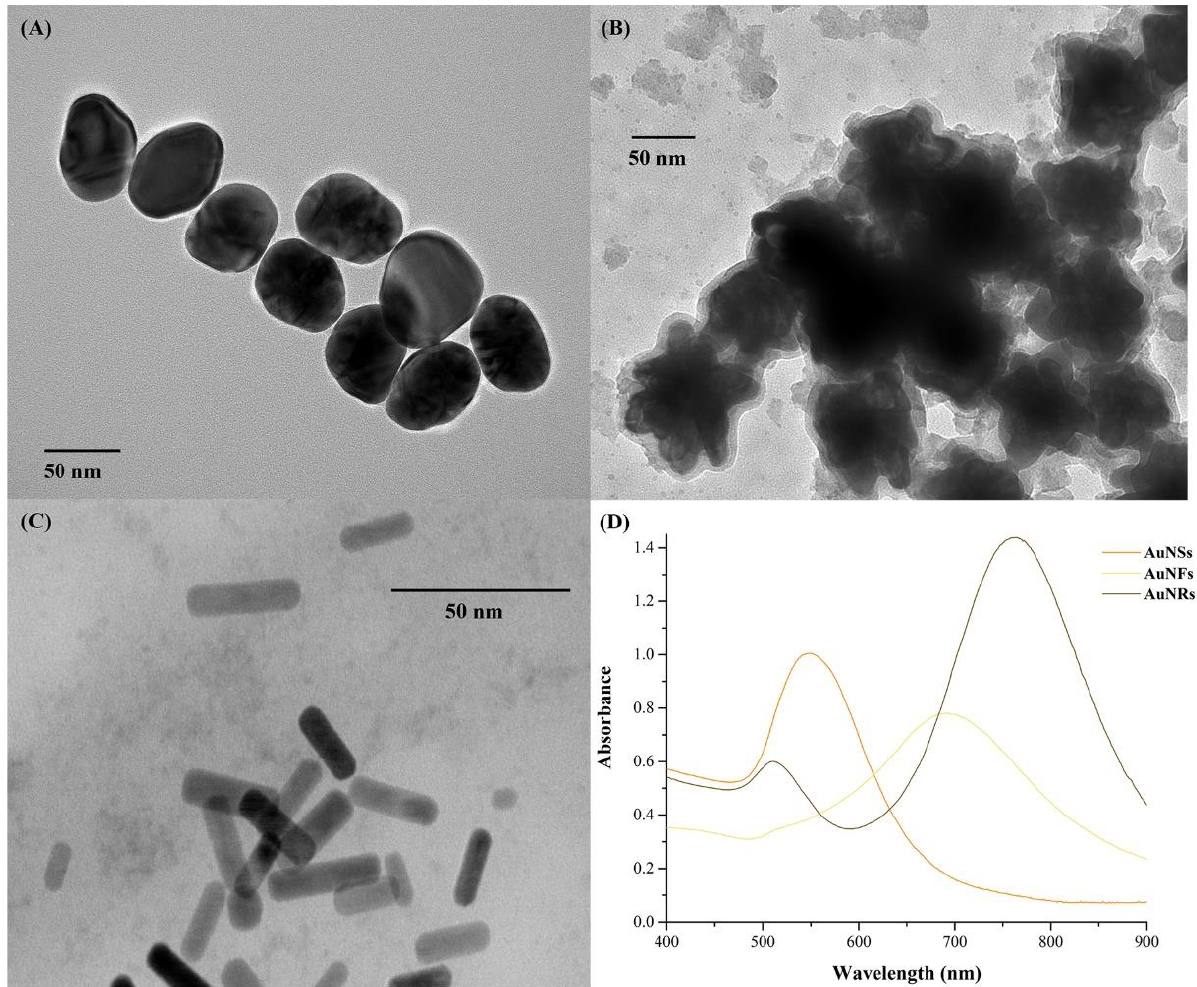
Figure 1. STEM images of ( A ) AuNSs, ( B ) AuNFs, and ( C ) AuNRs, and ( D ) UV-VIS spectra of AuNPs. The zeta potential (ZP) of as-synthesized AuNSs and AuNFs was − 61.0 ± 0.3 mV (pH 6.3) and − 58.1 ± 1.0 mV (pH 3.9), respectively. The negative surface charge of these particles is due to citrate capping. The AuNRs carried a strong positive surface charge (ZP = +71.3 ± 4.9 mV, pH 2.6) owing to the formation of CTAB-based cationic bilayer on their surface [48]. The hydrodynamic diameter (HD) of AuNSs and AuNFs was close